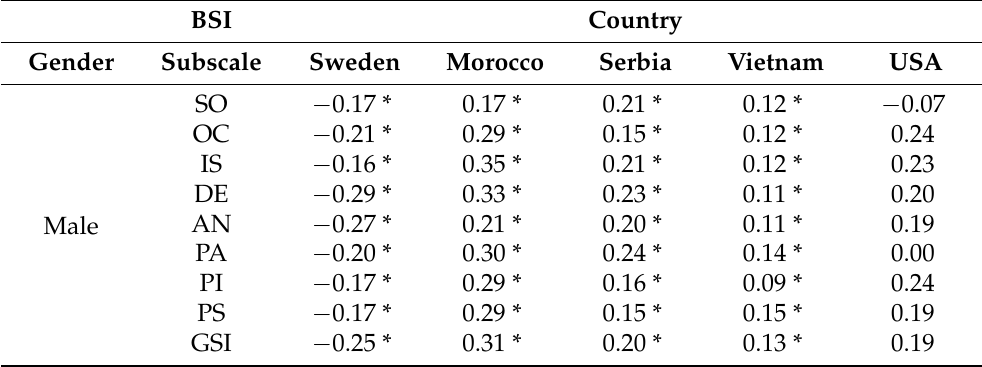
Table 5. Correlation coefficients between the COVID-19 impact and psychological